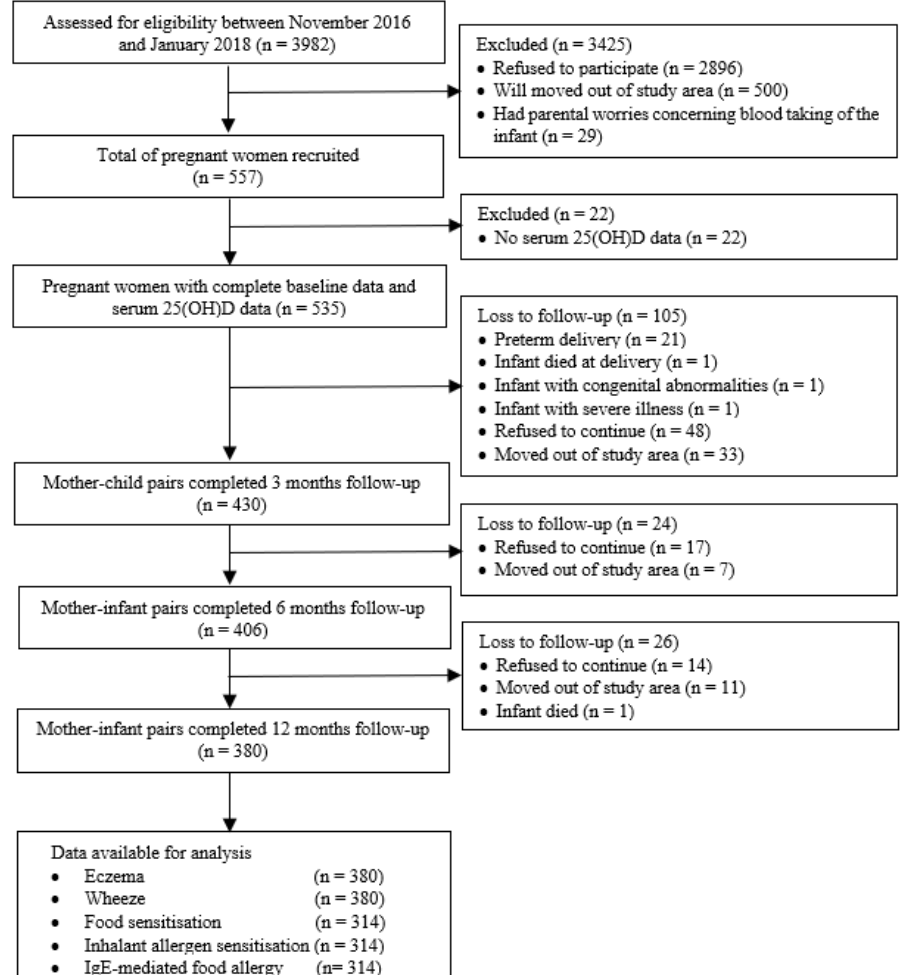
Figure 1. Flow chart of study respondents.